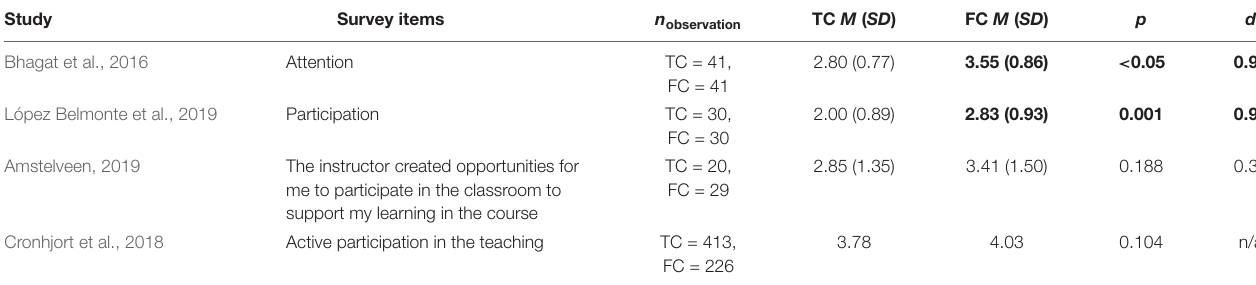
TABLE 2 | Survey results: Attention/participation by effect